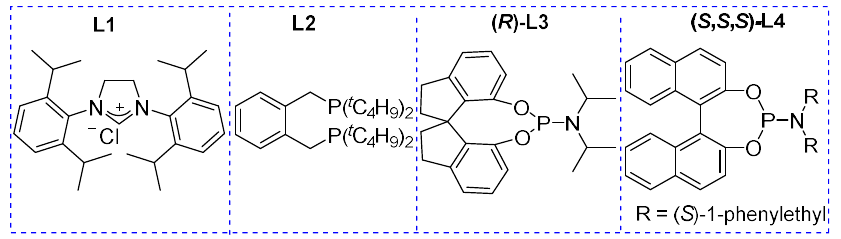
Figure 2. Scope of the ligands employed in the synthesis of compounds 8 , 9 , 12 , and 21